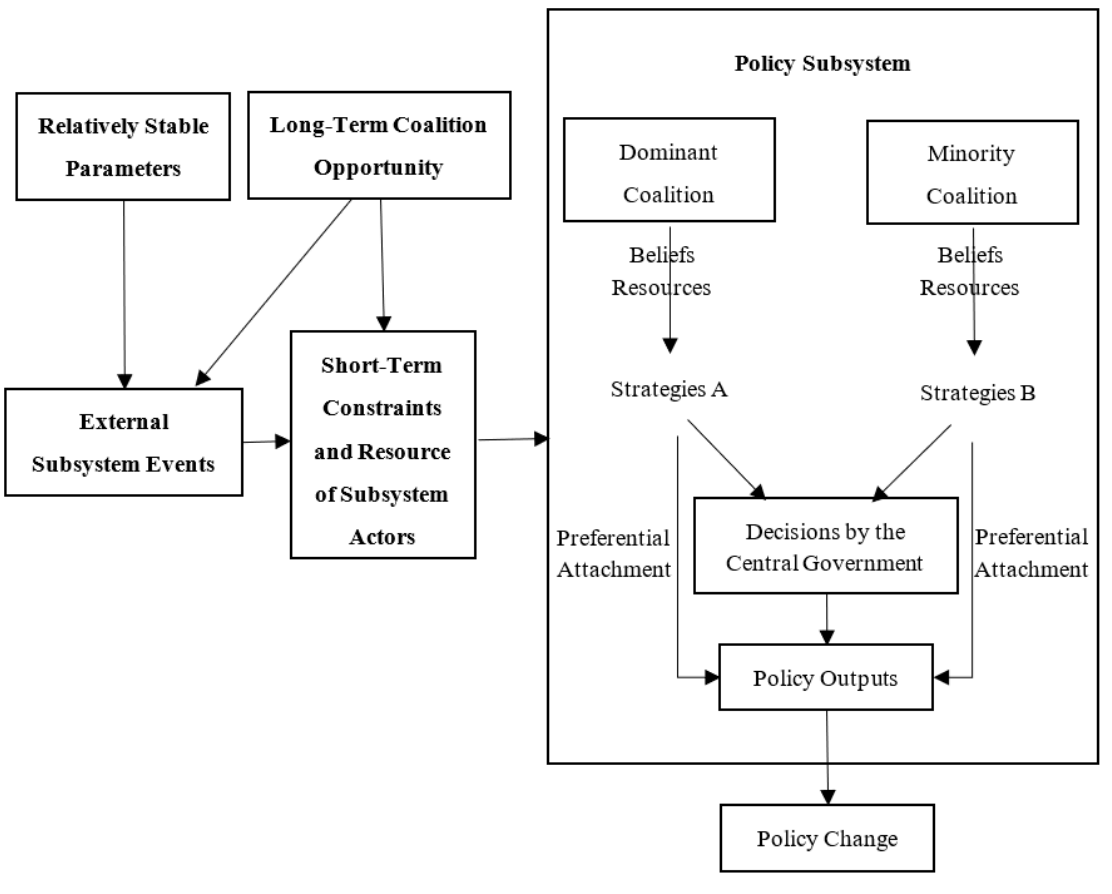
Figure 1. The Modified Figure 1. The Modi fi ed ACF.